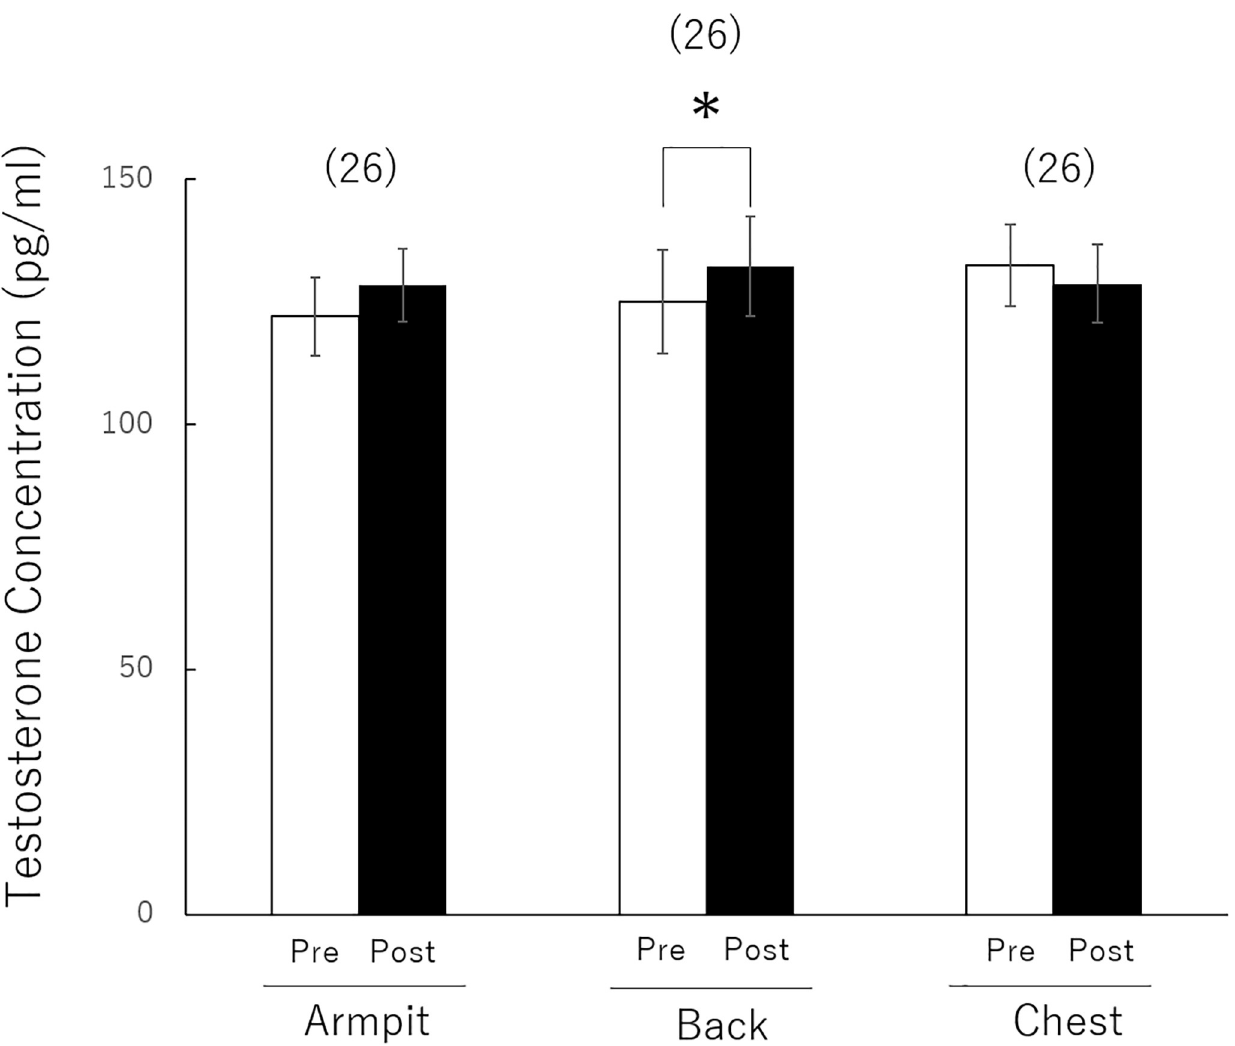
Fig 1. Comparisons of testosterone level changes to detect men’s response to odour of T-shirt regions in contact with the chest, armpit, and back in women with ovulatory phase. Data are expressed as the mean ± standard deviation. The number of participants in each group is given in parentheses. � P <